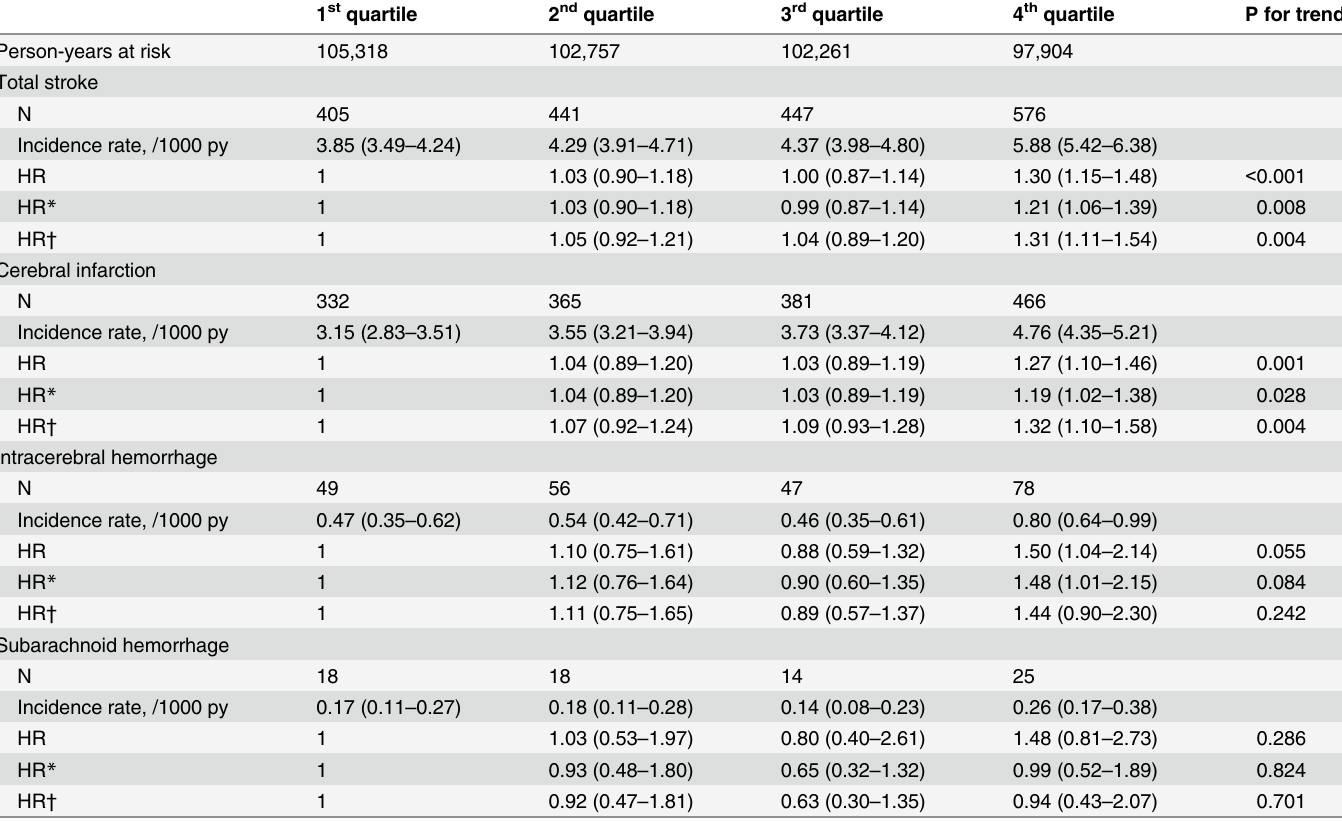
Table 2. Incidence rates, hazard ratios, and 95% confidence intervals for stroke in relation to quartiles of red cell distribution